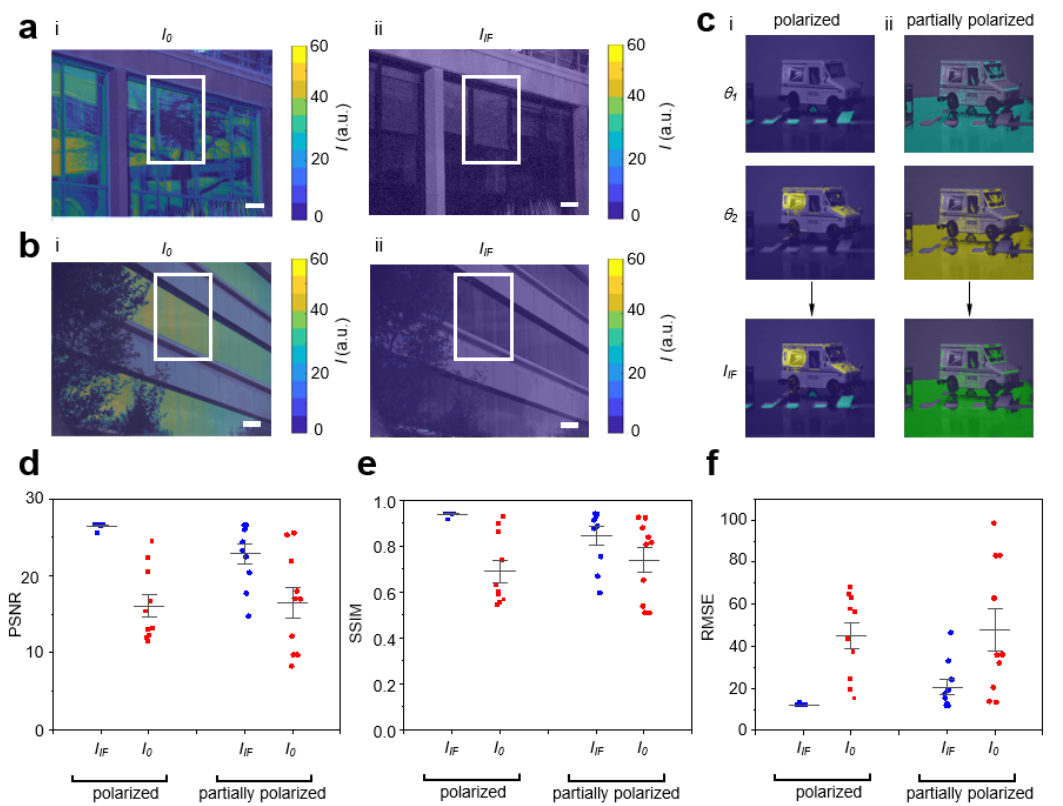
(Figure 3c). We quantitatively scored fusion image quality using PSNR, SSIM and RMSE. For polarized and partially polarized lighting obstructions, fusion images showed an increase in PSNR (Figure 3d) and SSIM (Figure 3e). Fusion images displayed a decrease in RMSE (Figure 3f) for polarized and partially polarized lighting obstructions. While image quality was higher for polarized lighting obstructions, these results support that IF also improves image quality for partially polarized lighting obstructions. As specular reflections are usually at least partially polarized, IF can be used to classify and remove various lighting obstructions.